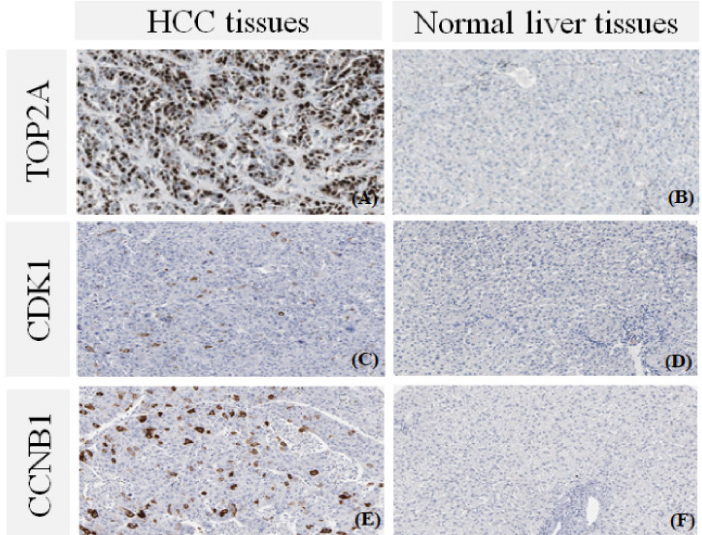
Figure 5. Immunohistochemistry of the five potential hub genes in liver cancer (HCC) and normal tissues from the Human Protein Atlas (HPA) database and previous studies [2,33]. Protein levels of ( A ) TOP2A in HCC tissue; ( B ) TOP2A in normal liver tissue; ( C ) CDK1 in HCC tissue; ( D ) CDK1 in normal liver tissue; ( E ) CCNB1 in HCC tissue; ( F ) CCNB1 in normal liver tissue. Biology 2021 , 10 , x